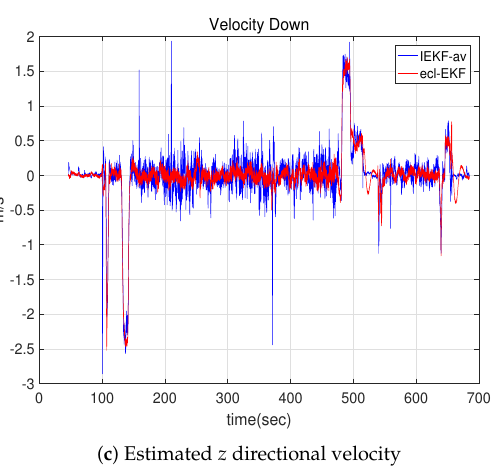
Figure 12. Velocities estimated by IEKF-av and ecl-EKF for quadrotor flight